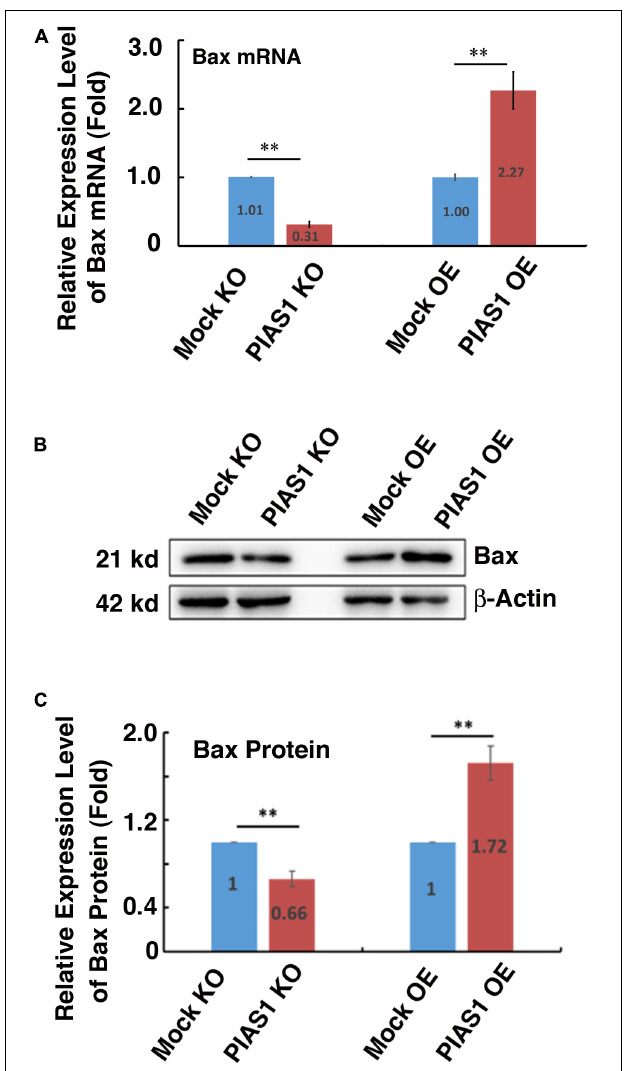
FIGURE 4 | PIAS1 regulates expression of the pro-apoptotic protein Bax in lens epithelial cells. (A) qRT-PCR analysis of the mRNA expression level of Bax in MOCK-KO, PIAS1-KO, MOCK OE (pEGFP- α TN4-1), and PIAS1-OE (pEGFP-PIAS1- α TN4-1) cells. Cp values of each sample were normalized with the Cp value of β -actin. (B) Western blot analysis of the protein expression level of Bax in MOCK-KO and PIAS1-KO, MOCK OE (pEGFP- α TN4-1), and PIAS1-OE (pEGFP-PIAS1- α TN4-1) cells. The β -actin was used as a loading control. (C) Quantification of the Western blot results in panel (B) . All experiments were repeated three times. Error bar represents standard deviation, N = 3. ∗∗ p <